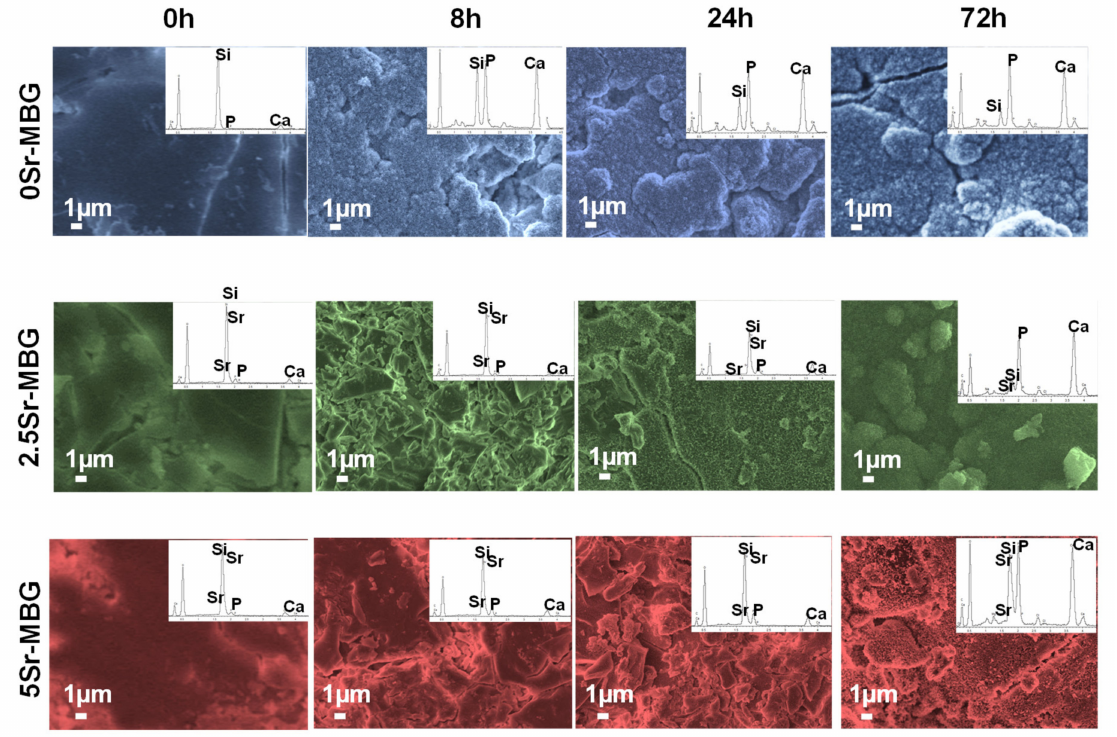
Figure 5. Scanning electron microscopy (SEM) micrographs and EDS spectra of di ff erent MBG disks soaked in SBF between 0 and 72 h, and their corresponding EDS